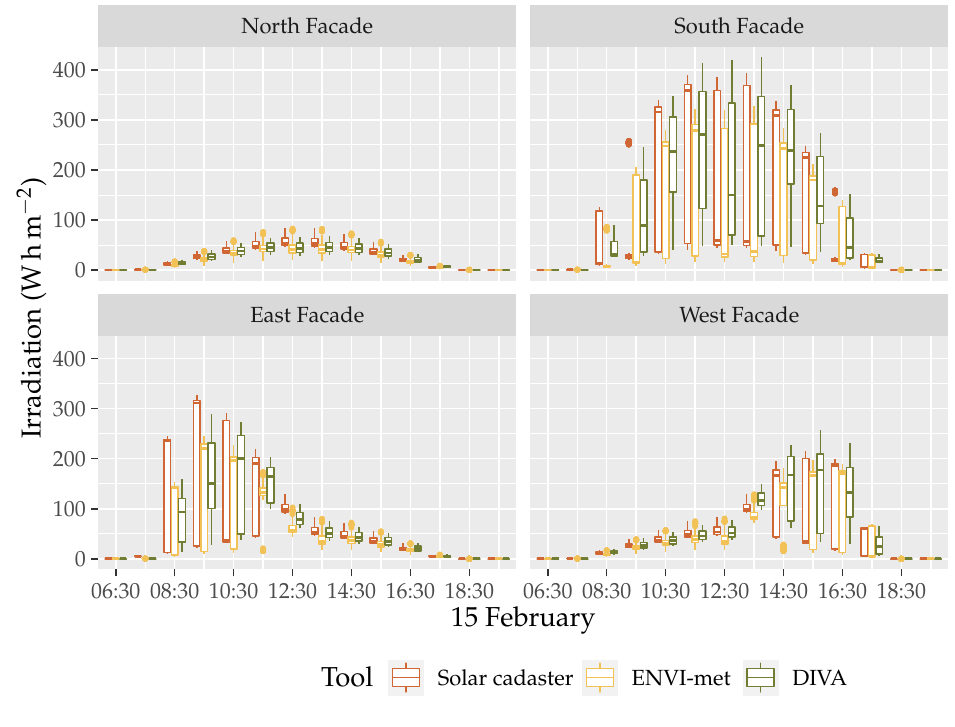
Figure 15. Distribution of the irradiance over the vertical facades for the homogeneous district in February.